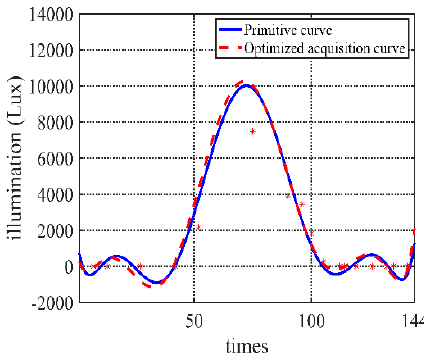
Figure 13. Algorithm illumination value acquisition and the real data.